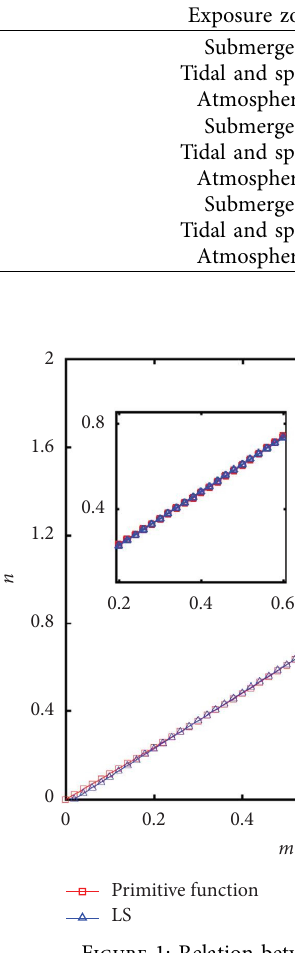
Figure 1: Relation between n and m